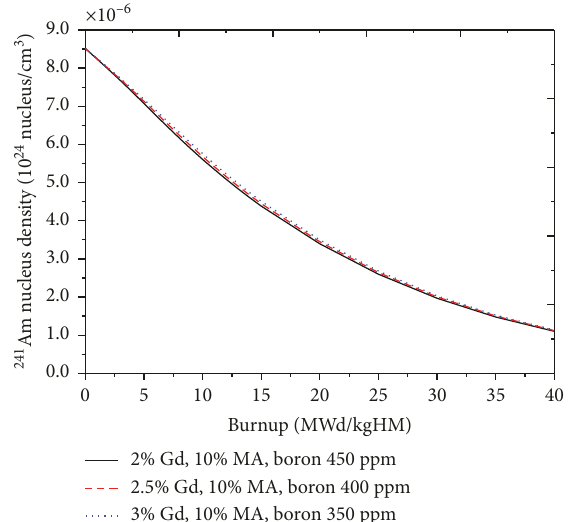
Figure 12: The k-inf versus burnup when loading 10wt.% of MAs and reducing GD to 3wt.%.